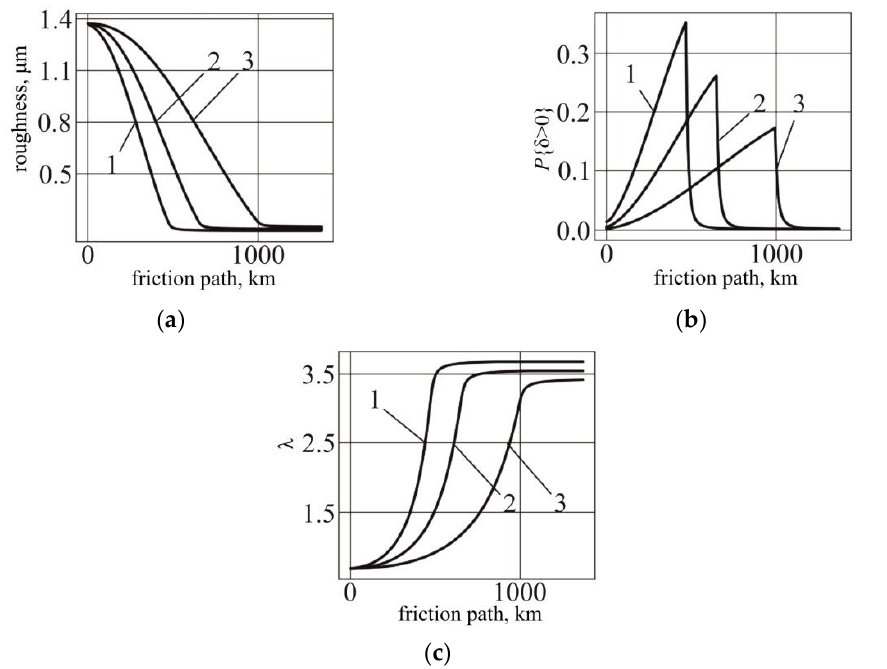
Figure 3. Friction characteristics ( a ) roughness of the bottom surface, ( b ) contact area share, ( c ) criterion λ of the lubrication mode: 3—load 10 kN; 2—load 30 kN; 1—load 90 kN.